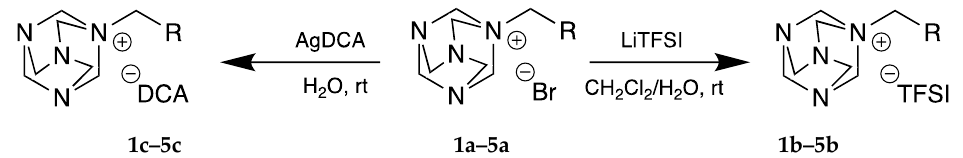
Figure 2. Scheme of metathesis reaction leading to HMTA derivatives with TFSI anion and DCA.